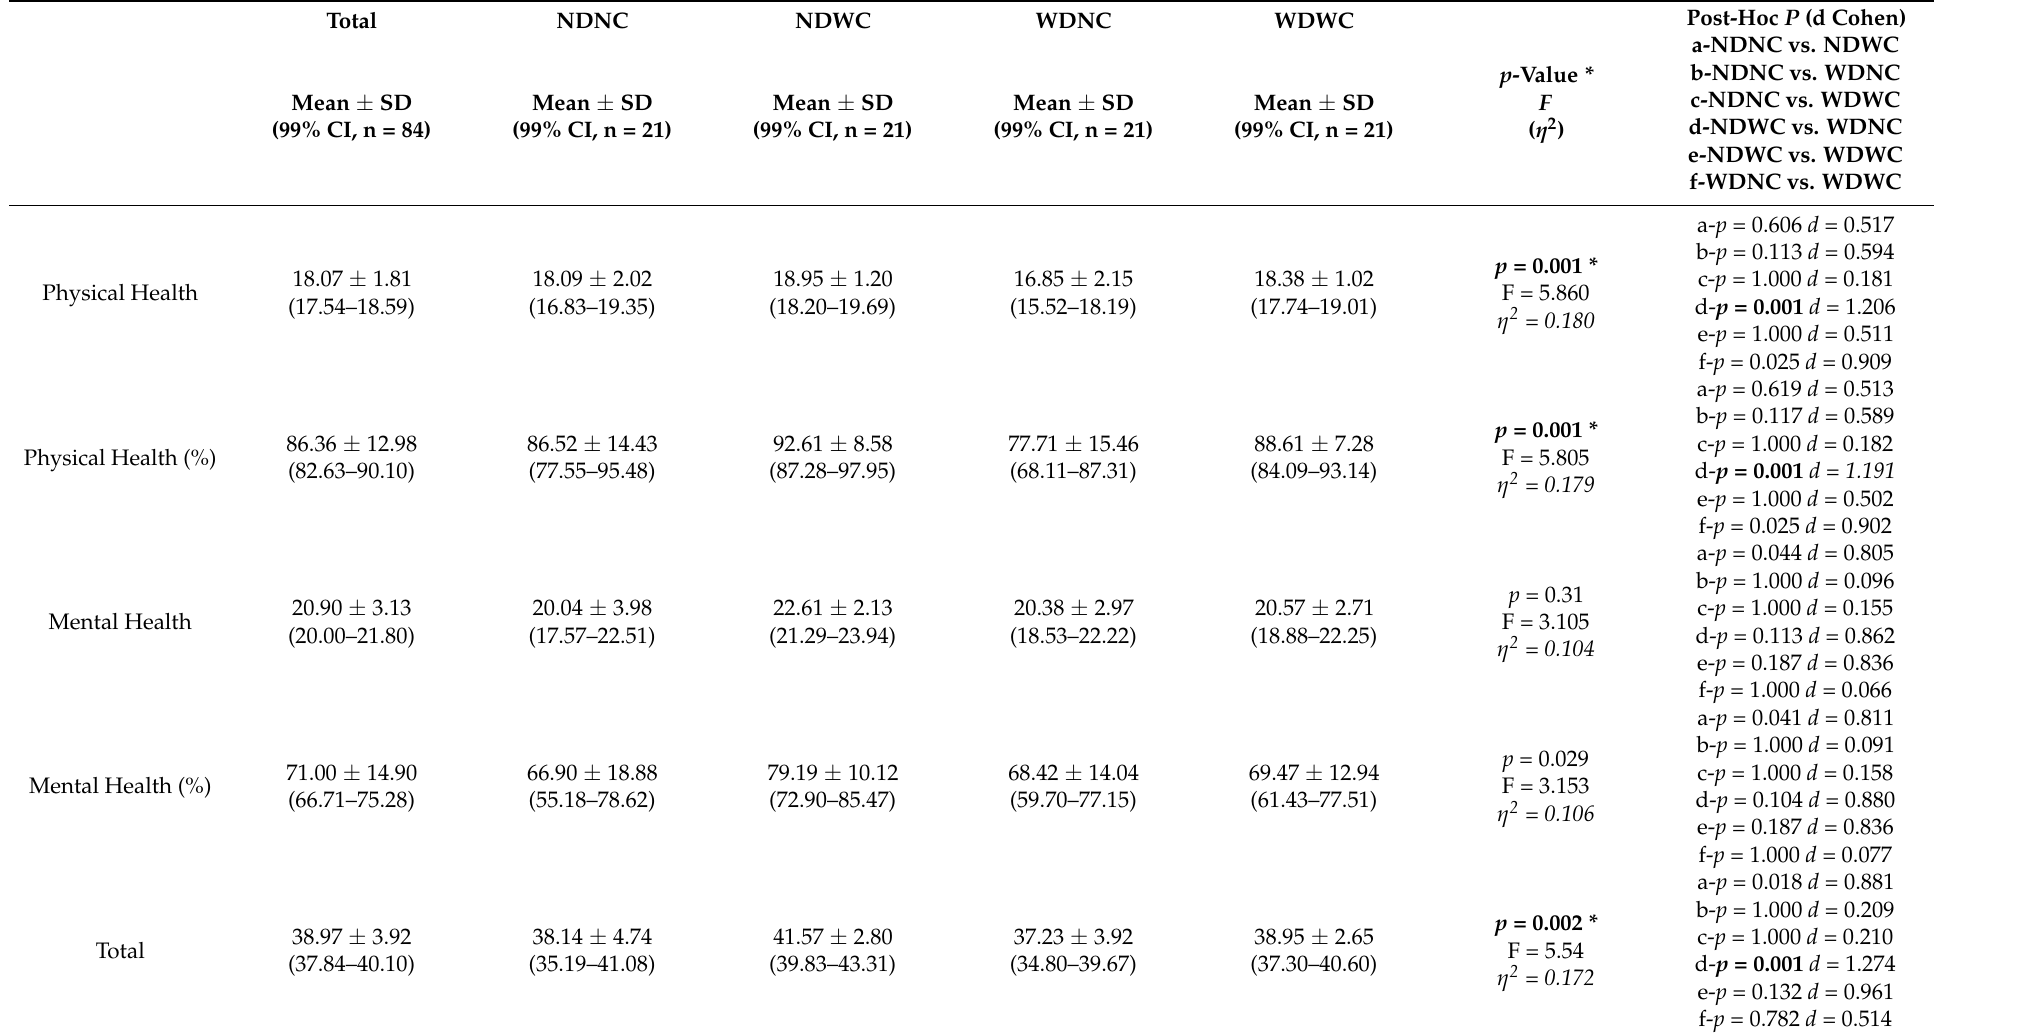
Table 3. Questionnaire